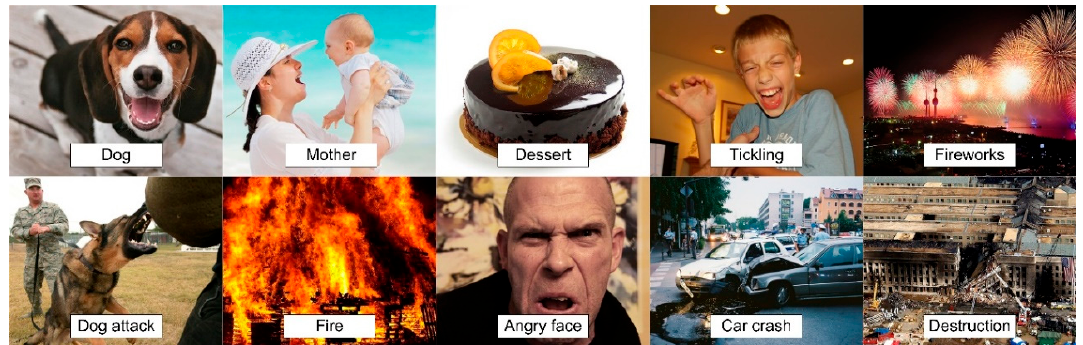
Figure 2. An example of 10 affective pictures with their tags from the Open Affective Standardized Image Set (OASIS) database [19]. Pictures with high arousal and valence for inducing the emotion of happiness (top row), and high arousal and negative valence for stimulation of fear (bottom row). Reproduced with permission from Kurdi, B.; Lozano, S.; Banaji, M.R., Introducing the open affective standardized image set (OASIS); published by Springer, 2017.